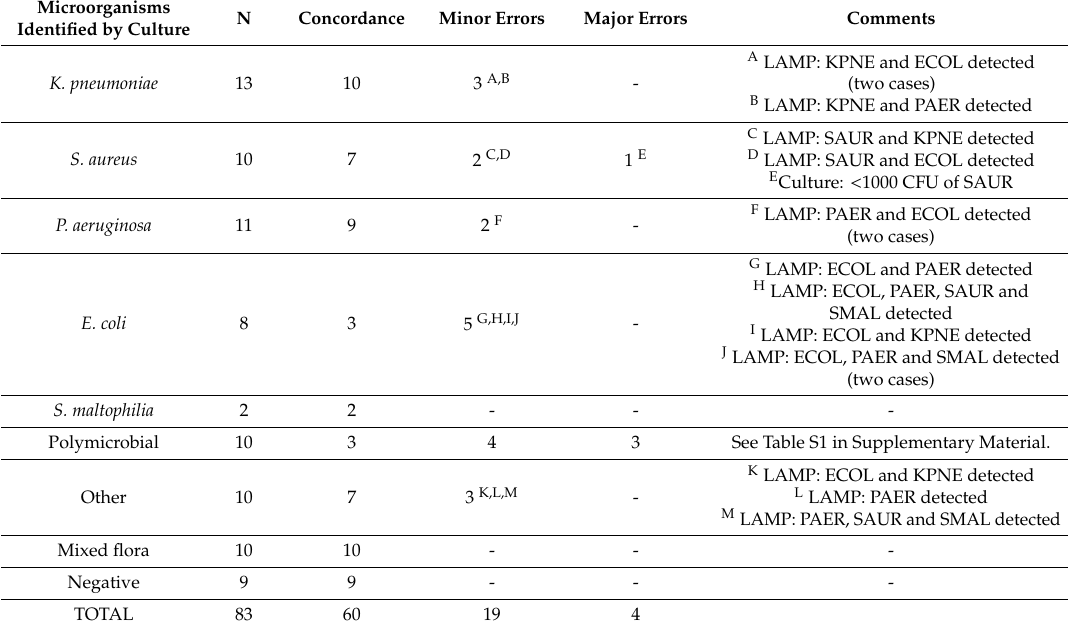
Table 3. LAMP results from BAS / EA samples according to the result obtained by culture. Microorganisms Identified by